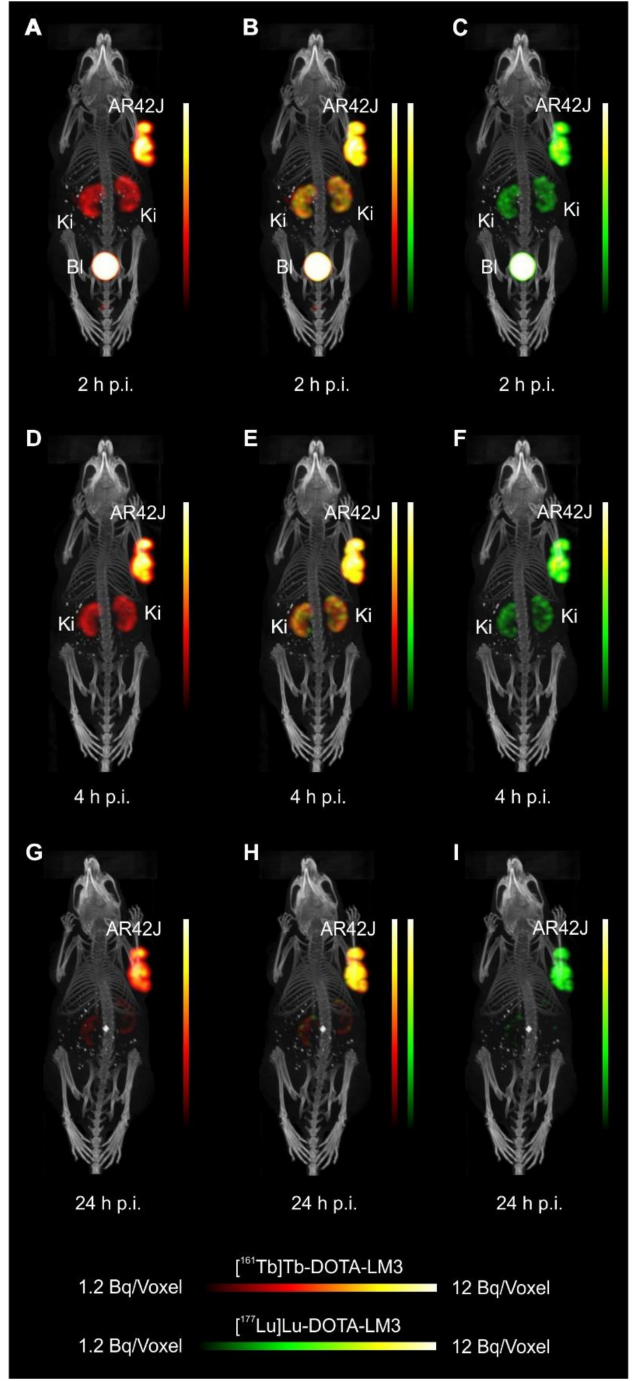
Figure 4. Dual-isotope SPECT/CT images of AR42J tumor-bearing mice shown as MIPs 2 h, 4 h and 24 h after injection of [ 161 Tb]Tb-DOTA-LM3 (15 MBq, 0.5 nmol/mouse) and [ 177 Lu]Lu-DOTA-LM3 (15 MBq, 0.5 nmol/mouse). ( A – C ) Scans acquired 2 h p.i. of the radiopeptides; ( D – F ) Scans acquired 4 h p.i. of the radiopeptides and ( G – I ) Scans acquired 24 h p.i. of the radiopeptides. ( A , D , G ) Re- constructions based on the X-rays and γ -lines of terbium-161; ( B , E , H ) Reconstructions based on the X-rays or γ -lines of terbium-161 and on the γ -lines lutetium-177; ( C , F , I ) Reconstructions based on the γ -lines of lutetium-177. AR42J = SSTR-positive tumor xenograft; Ki = kidney; Bl = urinary